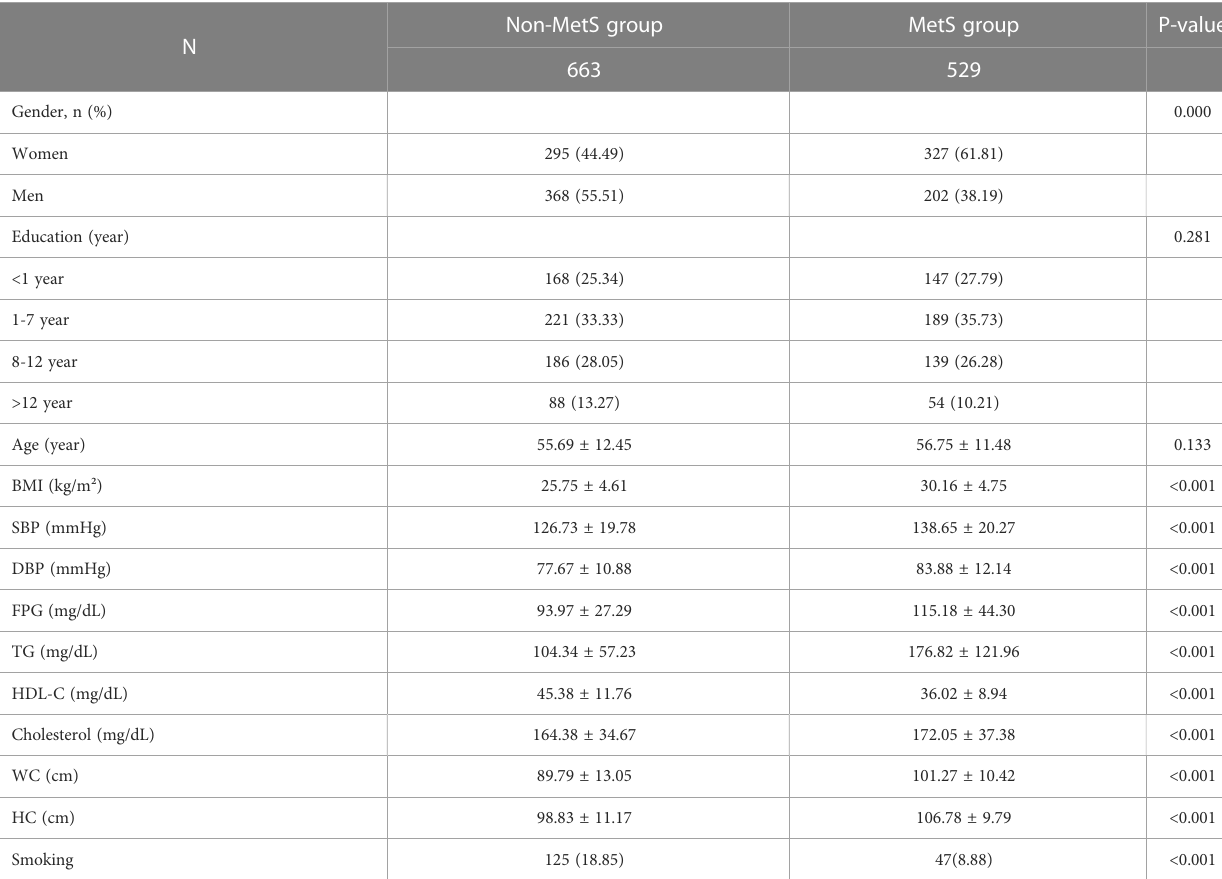
TABLE 1 The clinical characteristics and biochemical indices between the MetS group and non-MetS